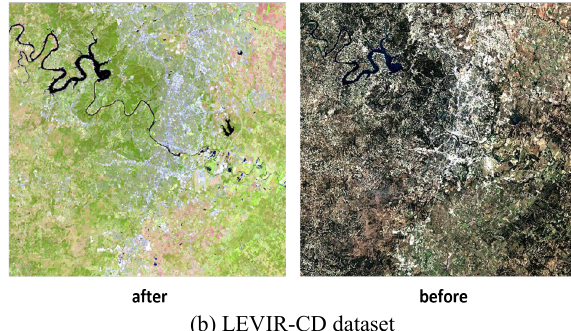
Figure 3 . Experimental data preview of spatial distribution in the dual-temporal